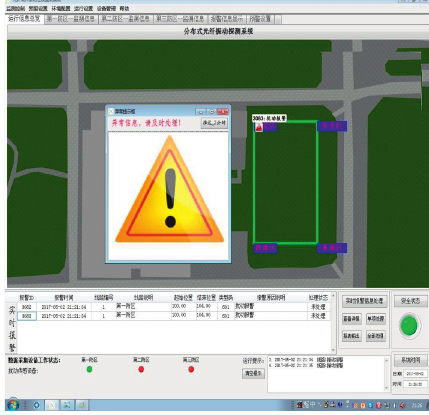
Figure 14: Alarm processing interface diagram. Figure 16: Data query module interface diagram.